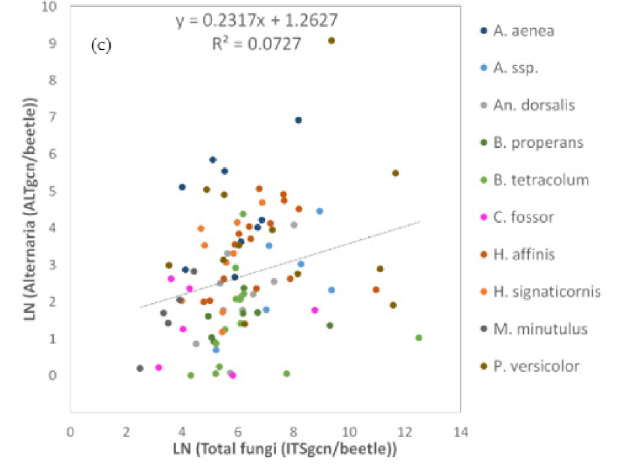
Figure 6. Effects on the load of fungal DNA (genome copy numbers, gcn) in samples of carabid beetles, comprising the body surface and inner body parts. ( a ) Effects of body weight (mg) on the load of total fungi (ITSgcn/beetle). ( b ) Effects of body weight (mg) on the load of Alternaria (ALTgcn/beetle). ( c ) Effects of the load of total fungi (ITSgcn/beetle) on the load of Alternaria DNA (ALTgcn/beetle). The carabid species are indicated in different colors in Figure c. Species code according to Table 2 (abbreviations long). The dotted lines show a linear trend combined for all carabid